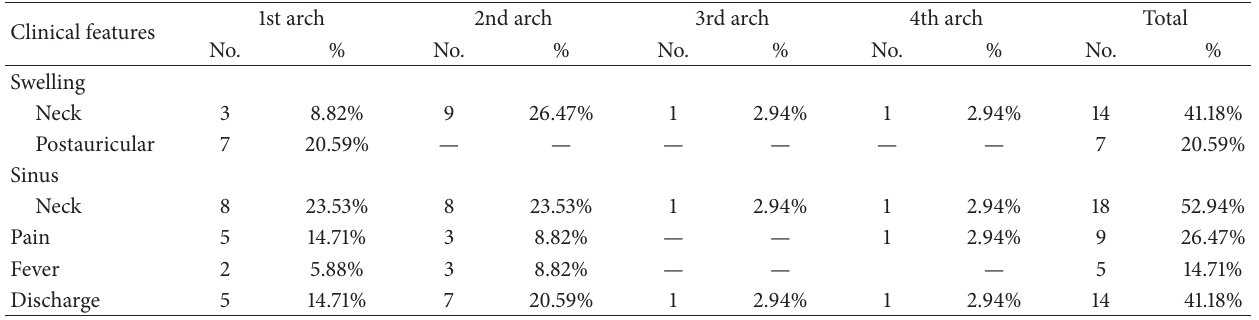
Table 3: Clinical